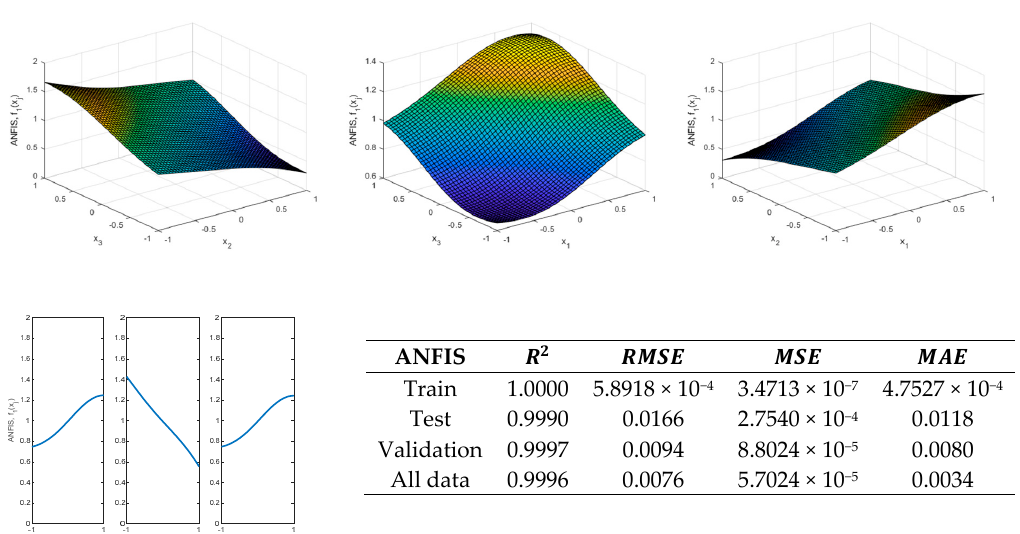
Figure 27. Response surface obtained with the zero-order Sugeno FIS employed for modeling f 1 using four Gaussian membership functions for the inputs and the proposed method for tuning the FIS using an ANFIS (Number of Epochs = 10, k FIS = 1.16, N FIS = 2.67